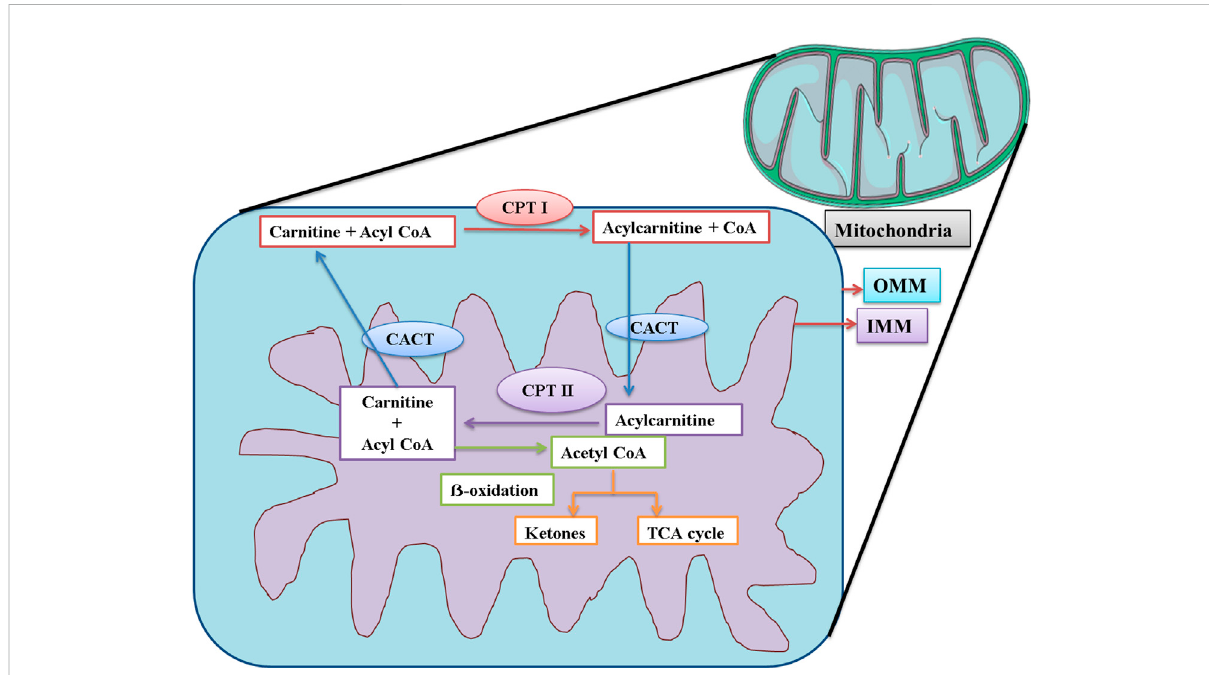
FIGURE 8 SchematicrepresentationofthefunctionsofCPTI,CPTII,andCACTinmitochondria.CPTIispresentatOMM.CPTIattachesalong-chainfatty acid,acylCoA(palmitoyl-CoAandoctadecenyl-CoA)tocarnitine,andtheresultantacylcarnitineistransportedtothemitochondrialmatrixbyCACT. CACT islocated attheIMM. Once inside themitochondria, acylcarnitineis againconverted to freecarnitineand Acyl CoA. This freecarnitineis again transportedbyCACT.TheacylCoAundergoes β -oxidationandisconvertedtoacetylCoA.TheacetylCoAcanbeconvertedintoketonebodies or enter the TCA cycle. CPT I: carnitine palmitoyltransferase I; CPT II: carnitine palmitoyltransferase II; CACT: mitochondrial carnitine/acylcarnitine carrier protein; OMM: outer mitochondrial membrane; IMM: inner mitochondrial membrane.